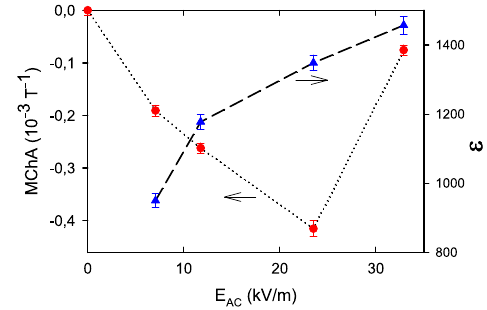
Fig. 4 Electric fi eld dependence. Excitation electric fi eld dependence of the magnetochiral anisotropy (MChA, red balls) and dielectric constant (blue triangles) of a + poled TGS sample at 321.05 K at 50 kHz and B = 2 T. Lines are guides to the